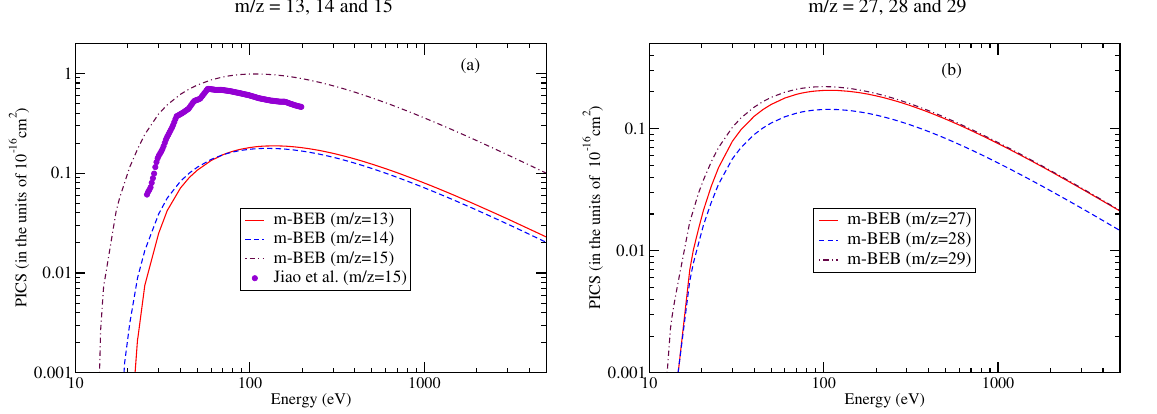
Figure 9. Partial ionization cross-sections for different fragments of nitromethane [90] for ( a ) m / z = 13–15, ( b ) m / z = 27–29.